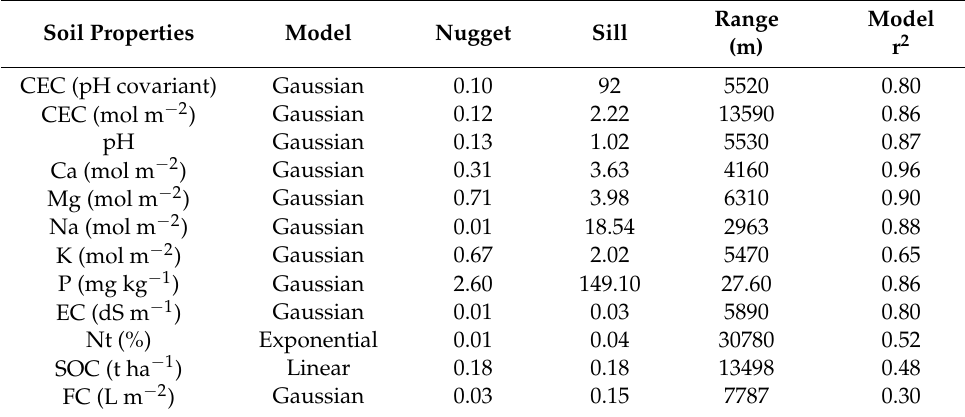
Table 2. Characteristics of semivariogram models of soil